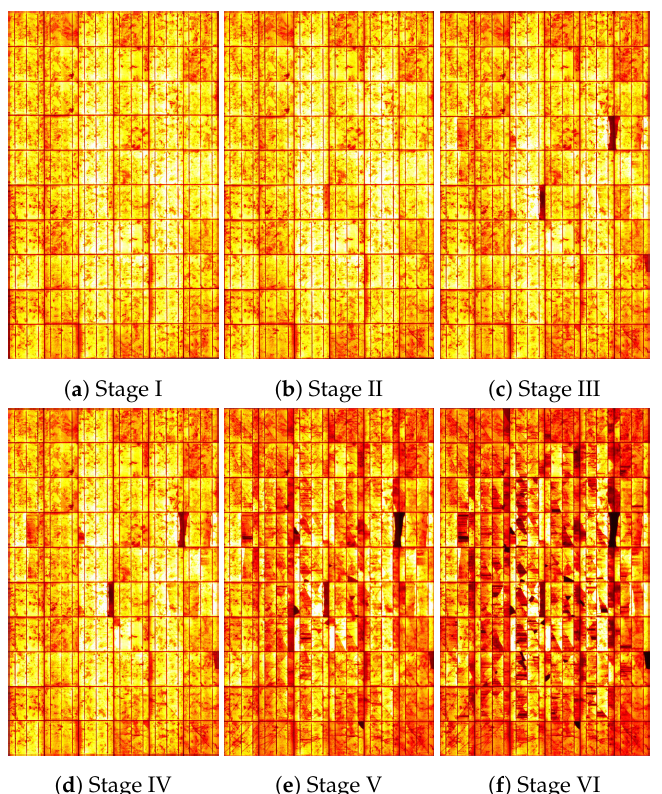
Figure A3. EL images of module #1, measured at STC I sc current bias, before the accelerated stress test (Stage I), and after each stress stage described in Table 1.